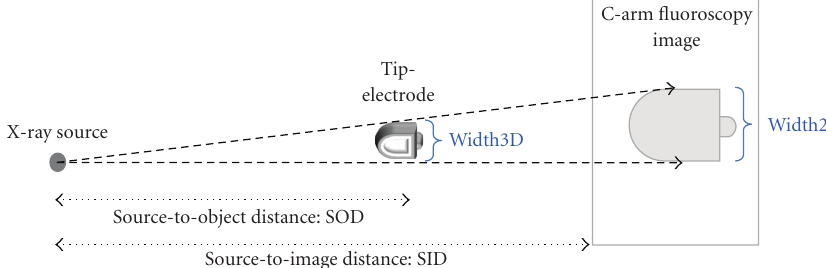
Figure 3: Geometric model relating the size of the electrode projection and the distance from the C-arm source.